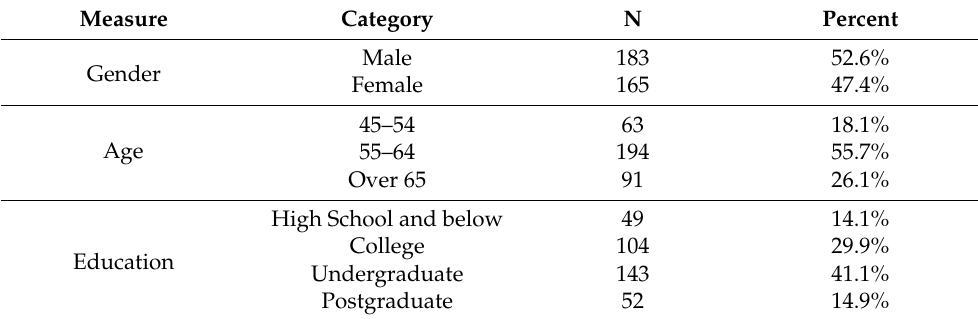
Table 2. Demographic profile of respondents, N =